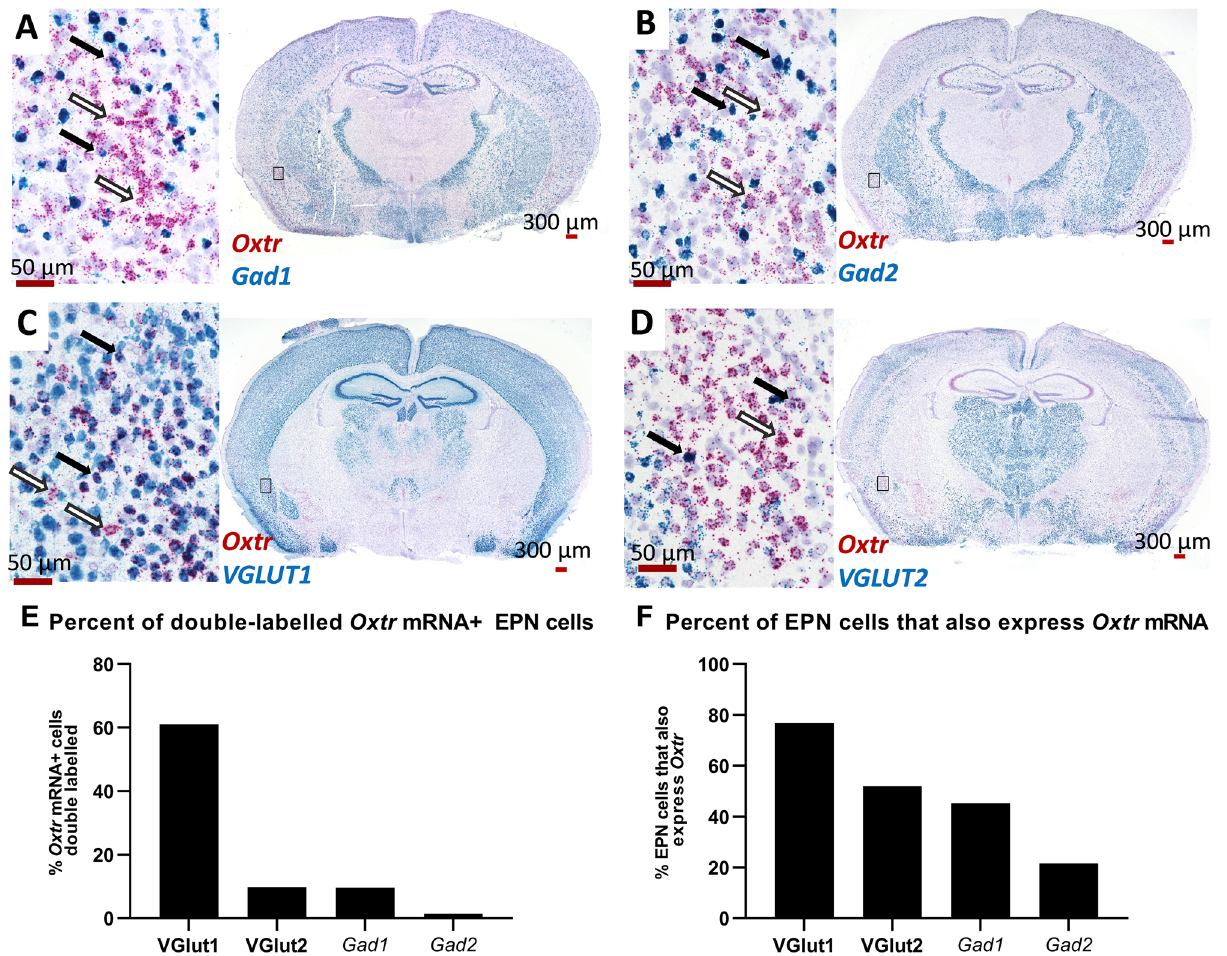
Figure 2. RNAscope in situ hybridization indicates that most of the endopiriform nucleus (EPN) cells are VGLUT1 ( Slc17a7 ) positive and ~ 60% of these cells co-express Oxtr , with a small population of GABAergic Oxtr + cells. Some neurons that express Oxtr mRNA (red) co-express mRNA for the GABAergic markers (black arrows), Gad1 ( A , blue) or Gad2 ( B , blue). However, most Oxtr expressing cells were negative for these markers (white arrows). Most of the Oxtr expressing neurons in EPN co-express the markers for VGLUT1 ( Slc17a7 ) ( C , E , blue, black arrows) with only a few that expressed only Oxtr ( C , F , white arrows). Expression of the marker for VGLUT2 ( Slc17a6 ) ( D , blue) was low in EPN but some co-expression with Oxtr was detected (black arrows). The percentage of Oxtr expressing EPN neurons that co-express one of the other markers studied here is shown in E , while the percent of EPN neurons that express one of the other markers that co-express Oxtr is shown in F